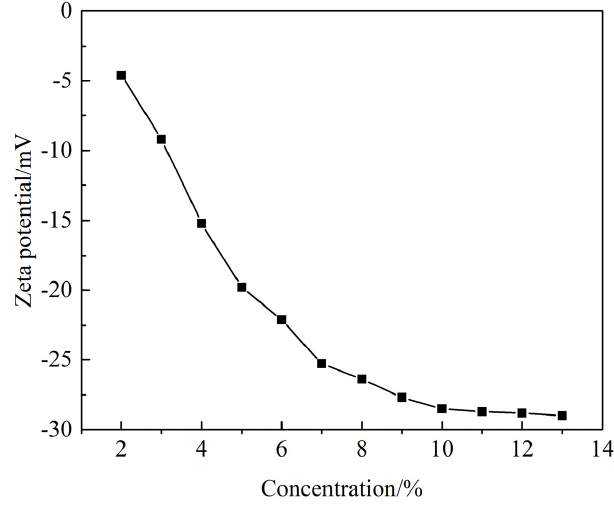
Figure 8. The zeta potential of the pendimethalin suspensions with different concentrations.